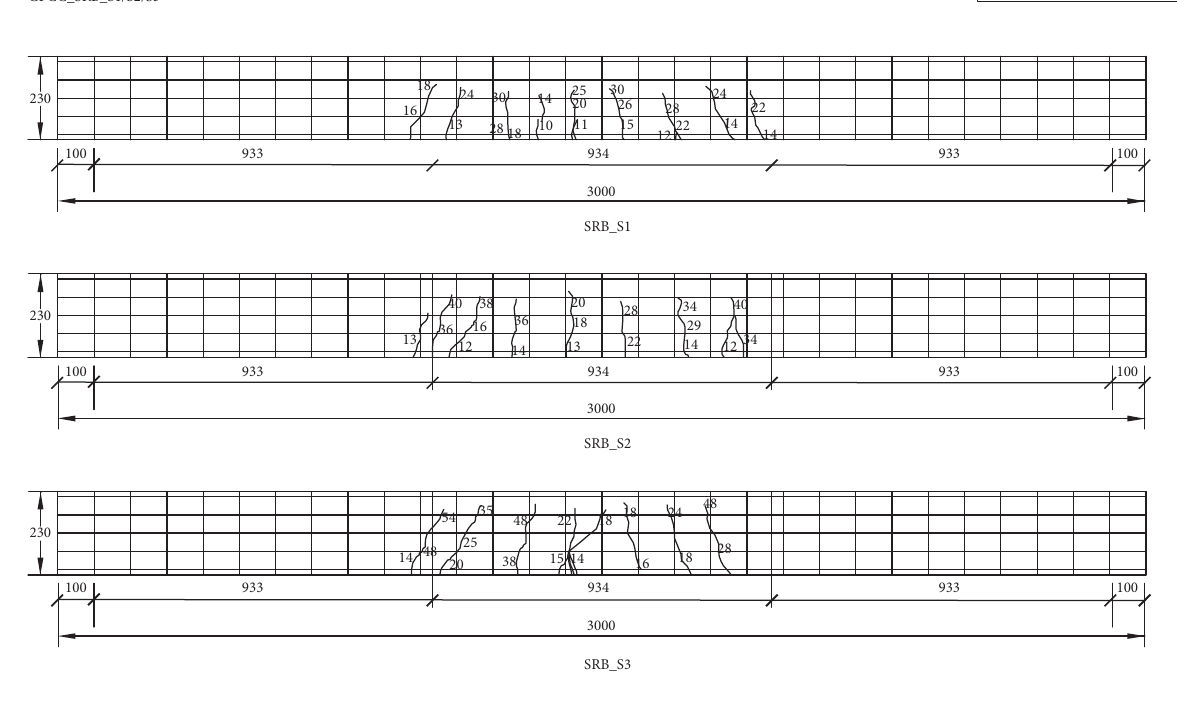
Figure 8: Crack pattern of GPCC for singly reinforced beam